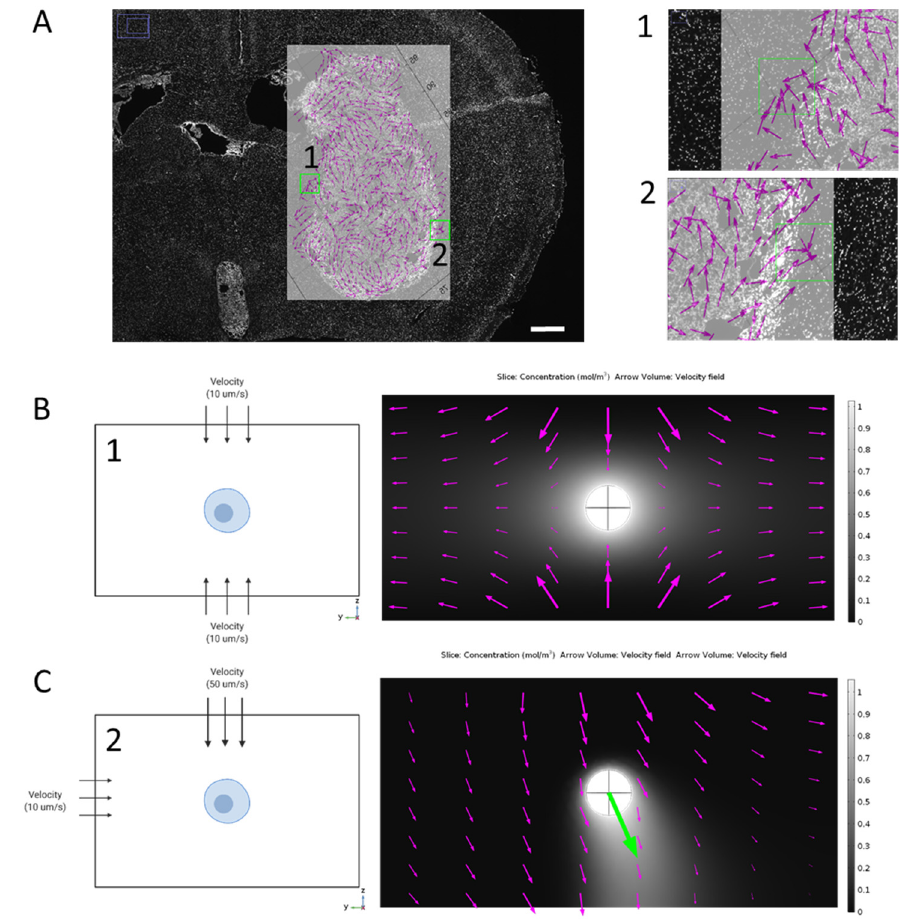
Figure 2. Multidirectional flow and its impact on gradient formation around a single cell. ( A ) MRI analysis of interstitial fluid flow magnitude and direction overlayed on histological sample showing flow heterogeneity and two specific regions of interest (1) and (2). Scale bar 0.5 mm. ( B ) Schematic of flow directed evenly on the top and bottom of the cell ( left ) and resulting flow pathways overlayed on top of bound CXCL12 gradient ( right ) around a single cell (10 µ m diameter). ( C ) Schematic of flow directed above and to the left of the cell ( left ) and resulting flow pathway (magenta arrows) with corresponding resultant of flow direction (green arrow) overlayed on bound CXCL12 gradient ( right